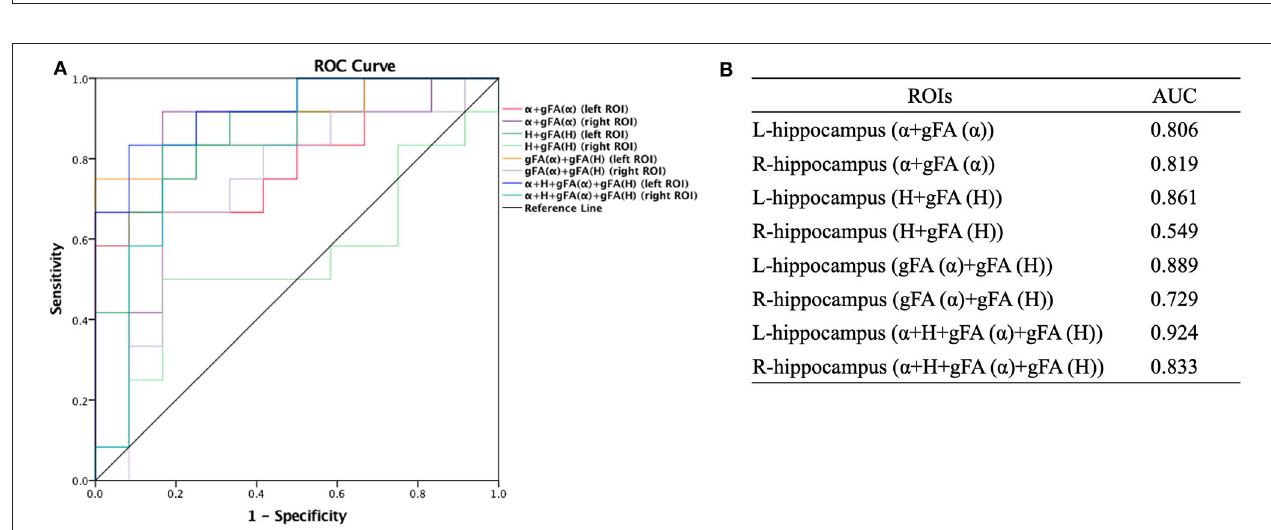
FIGURE 5 | Receiver-operating characteristic (ROC) curve was generated using the individual gFA values and directionally averaged values of α , H , and ADC for differentiating mild and moderate AD patients ( n = 12 in each group). (A,B) The area under the curve (AUC) of gFA( α ) and gFA( H ) values of the left hippocampus (AUC = 0.833, AUC = 0.826, separately) were larger than those of others. ROC, receiver operating characteristic; ROI, region of interest; gFA, generalized fractional anisotropy; ADC, apparent diffusion coefficient; AD, Alzheimer’s disease; AUC, area under the curve.